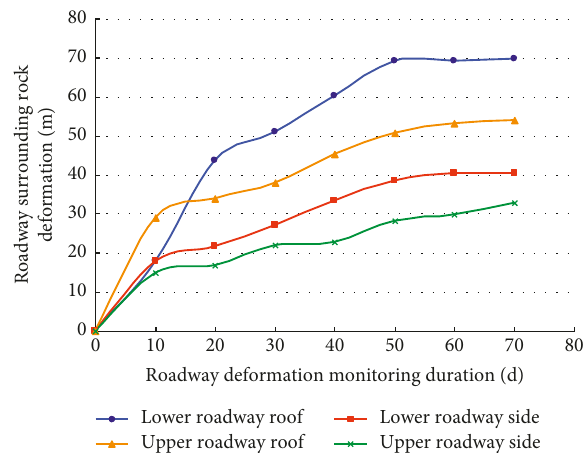
Figure 19: Surrounding rock deformation monitoring of staggered